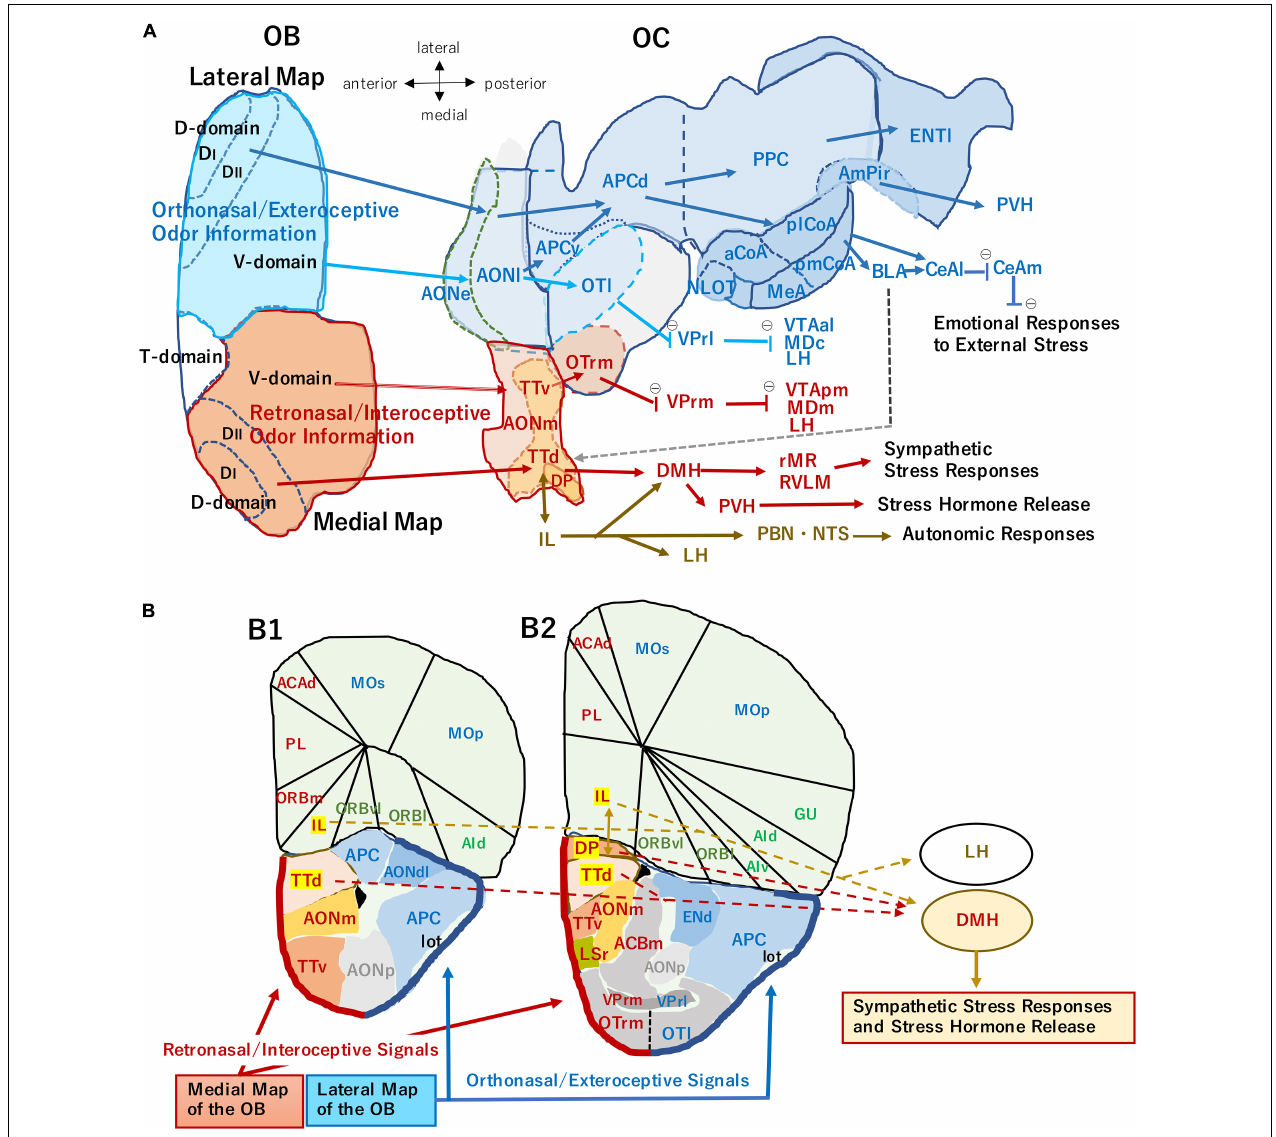
FIGURE 1 | (A) An unfolded map (ventral center view) of the mouse olfactory bulb (OB) and olfactory cortex (OC) illustrating two olfactory processing streams. The medial stream (magenta arrows) originates from the medial map of the OB (dark orange) and conveys retronasal/interoceptive information to the medial part of the anterior olfactory nucleus (AONm), ventral tenia tecta (TTv), dorsal tenia tecta (TTd), dorsal peduncular cortex (DP), and rostromedial part of olfactory tubercle (OTrm). OTrm sends inhibitory axons (marked by θ ) to the rostromedial part of ventral pallidum (VPrm). The VPrm projects inhibitory axons to the posteromedial part of ventral tegmental area (VTApm), medial part of mediodorsal nucleus in the thalamus (MDm), and lateral hypothalamus (LH). The TTd and DP project to the dorsomedial nucleus of hypothalamus (DMH), which projects to the sympathetic premotor neurons in the rostral medullary raphe region (rMR) and rostral ventrolateral medulla (RVLM) to generate sympathetic responses. The TTd and DP have reciprocal connections with infralimbic cortex (IL), which projects to the autonomic centers in the hypothalamus and brainstem, such as DMH, LH, parabrachial nucleus (PBN), and nucleus of solitary tract (NTS). The ventral part of DMH projects to the paraventricular nucleus of hypothalamus (PVH) and activates the hypothalamo-pituitary-adrenal axis to release stress hormones (Herman et al., 2016; Nakamura and Morrison, 2022). The lateral stream (blue arrows) originates from the lateral map of the OB (blue) and sends orthonasal/exteroceptive odor information to the external and lateral parts of the anterior olfactory nucleus (AONe, AONl), lateral part of the olfactory tubercle (OTl), ventral and dorsal parts of the anterior piriform cortex (APCv, APCd), posterior piriform cortex (PPC), nucleus of the lateral olfactory tract (NLOT), anterior, posterolateral, and posteromedial nuclei of the cortical amygdala (aCoA, plCoA, pmCoA), medial amygdala (MeA), amygdalo-piriform transition area (AmPir), and lateral entorhinal area (ENTl). The CoA projects to the basolateral amygdaloid complex (BLA) and lateral and medial nuclei of central amygdala (CeAl, CeAm) to induce emotional responses. A gray broken arrow from the amygdala to the DP/TTd indicates a putative route for the transmission of aversive orthonasal odor information to the DP/TTd-DMH pathway. The OTrl sends inhibitory axons to the rostrolateral part of ventral pallidum (VPrl). The VPrl projects inhibitory axons to the anterolateral part of ventral tegmental area (VTAal), the central part of mediodorsal nucleus in the thalamus (MDc), and LH. The unfolded map was modified from Mori and Manabe (2014), with permission